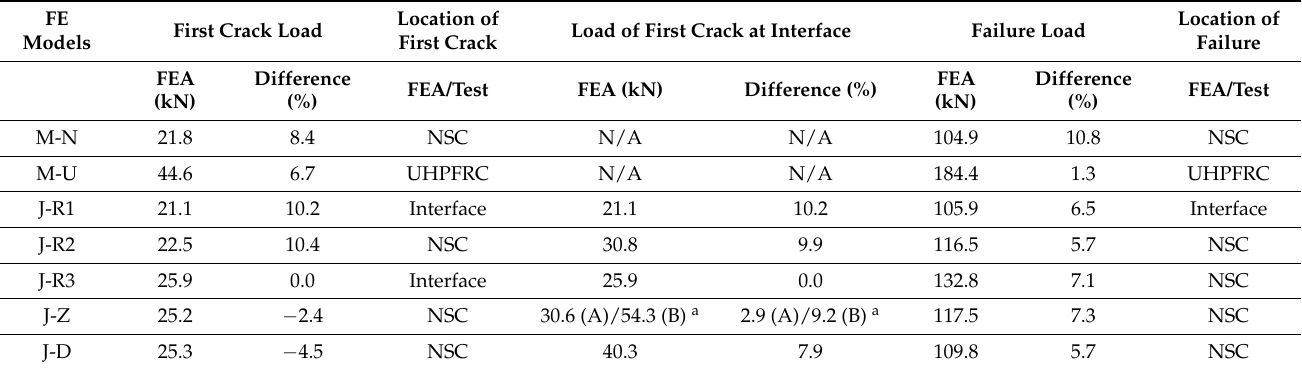
Table 6. Comparisons of crack details and corresponding loads between FE models and